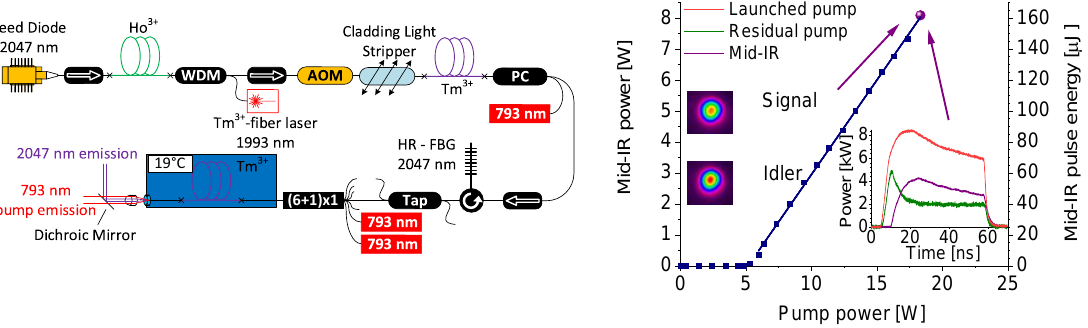
Figure 1: Experimental setup of the all-fiber MOPA. Figure 2: Combined mid-IR power versus launched pump power. The inset on the right shows the launched pump pulse (red) together with the residual pump (green) and the mid-IR pulse (purple). The insets on the left show the beam profile of signal and idler. A maximum mid-IR output power of 8.1 W (162 μ J pulse energy) is reached at a differential OPO efficiency of 61 % and a total OPO conversion efficiency of 44 %. The launched pump pulse, the residual pump and the combined mid-IR pulse are shown in the right inset of figure 2. The beam quality factors for signal and idler are obtained by separately measuring the beam diameters around the focus spot. An M 2 value of 2.2 and 2.0 is found for signal and idler, respectively. The left insets show the beam profiles of signal and idler. Further investigations will target the increase of average power and pulse energy by managing nonlinearities in the power stage of the pump